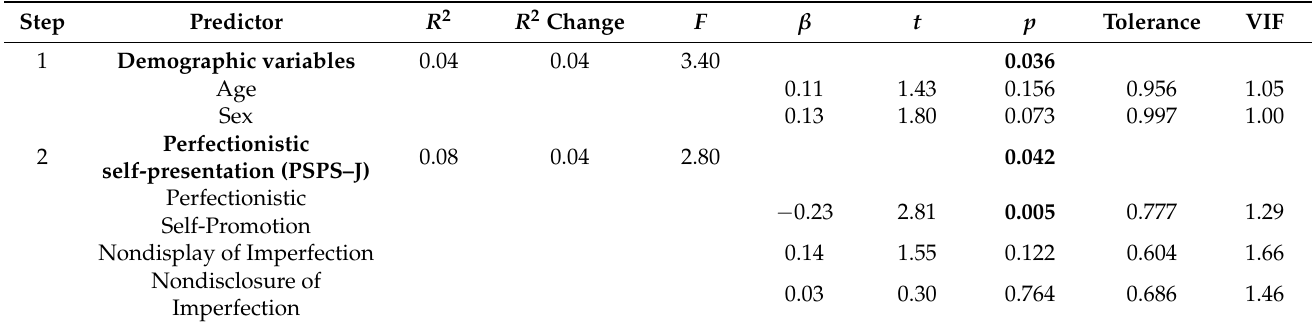
Table 4. Regression analysis predicting pain intensity